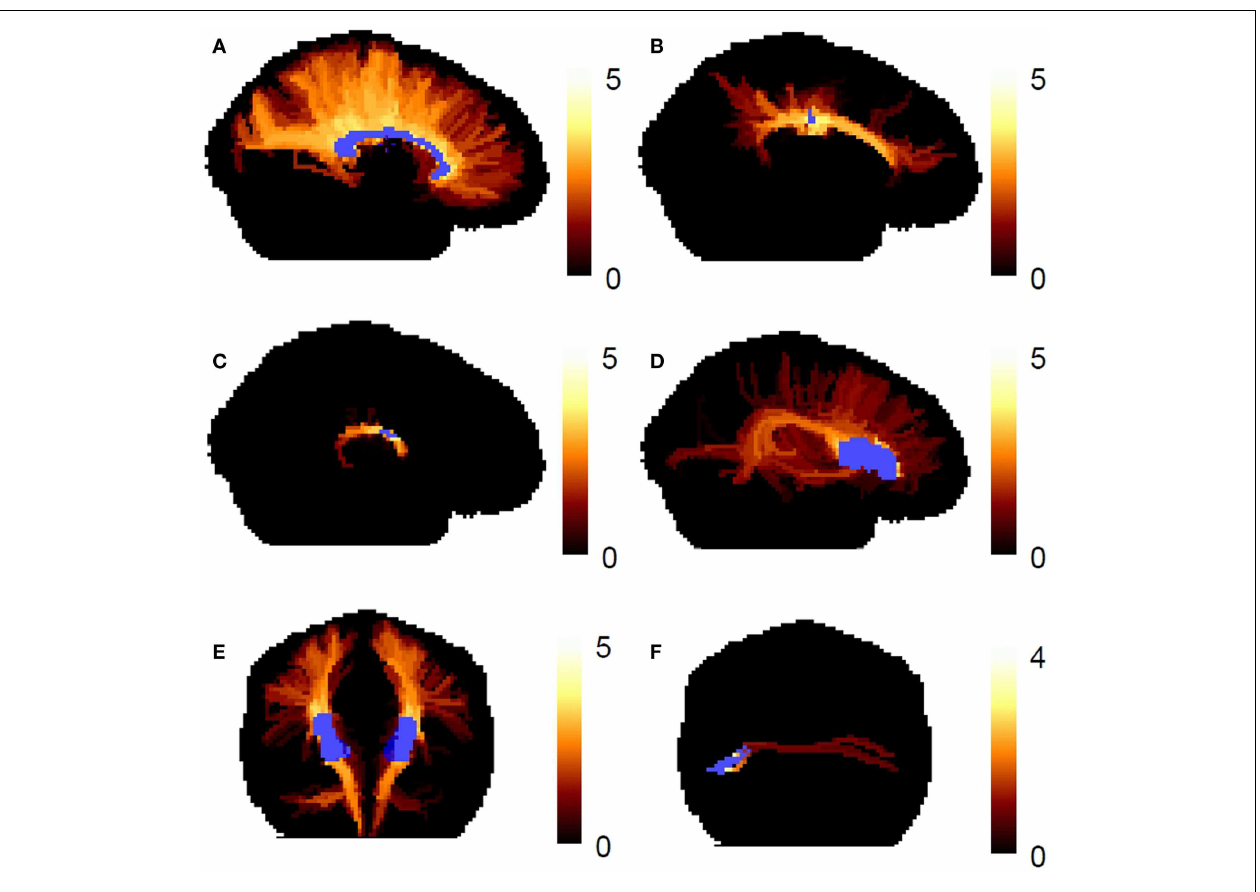
FIGURE 7 |The worst-case connectivity index map is shown in human fiber tract systems . (A) Corpus callosum, (B) cingulate bundle, (C) fornix, (D) association connections of Broca’s area (left hemisphere),